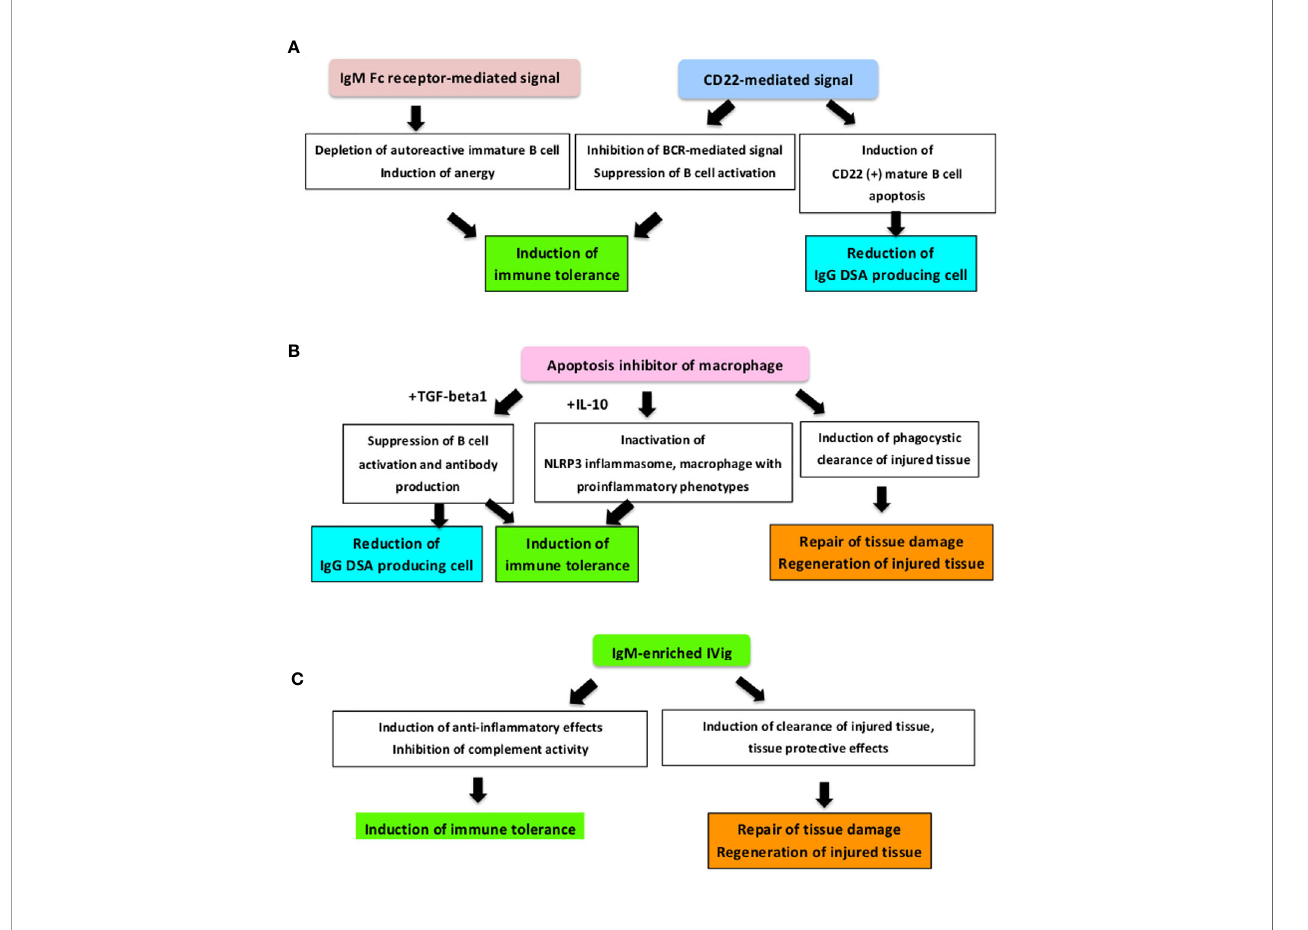
FIGURE 3 | How these novel applicable components improve the prognosis of AMR. We summarised the clinical potential of novel humoral immunity-associated components in AMR control and AMR development mechanisms. (A) As an IgM receptor, the FCu receptor-mediated signal controls harmful autoreactive IgG antibodies production and controls autoimmunity and in fl ammation through regulating immunoregulatory cells (37, 38, 216, 219, 222). In addition, this signal is associated with immune tolerance induction by promoting deletion and energy of immature B cells (38). CD22-mediated signaling also induces immune tolerance via CD22-CD22L interaction and CD22-mediated inhibition of the BCR-mediated signal (227, 228) and CD22 (+) mature B cell apoptosis (71). (B) As a scavenger protein, it has been reported that free Apoptosis inhibitor of macrophage (AIM) works to suppress in fl ammation, tissue injury and tissue regeneration through phagocytic activity during acute kidney injury (233 – 241) and AIM mediates immune tolerance induction by IL-10 and suppresses the immune response by inducing macrophages with immunosuppressive phenotype activation (35) and cooperates with TGF-beta to suppress B cell proliferation and antibody production (233). (C) As a polyclonal IgM antibody, IgM-enriched IVig strongly suppresses cell proliferation, has a inhibitory effect in complement activity (257, 258), and alleviates the humoral immunity-associated pathological condition in severe infection, organ ischemia, and transplants (42, 253 – 256, 258, 259). BCR, B cell receptor; DSA,